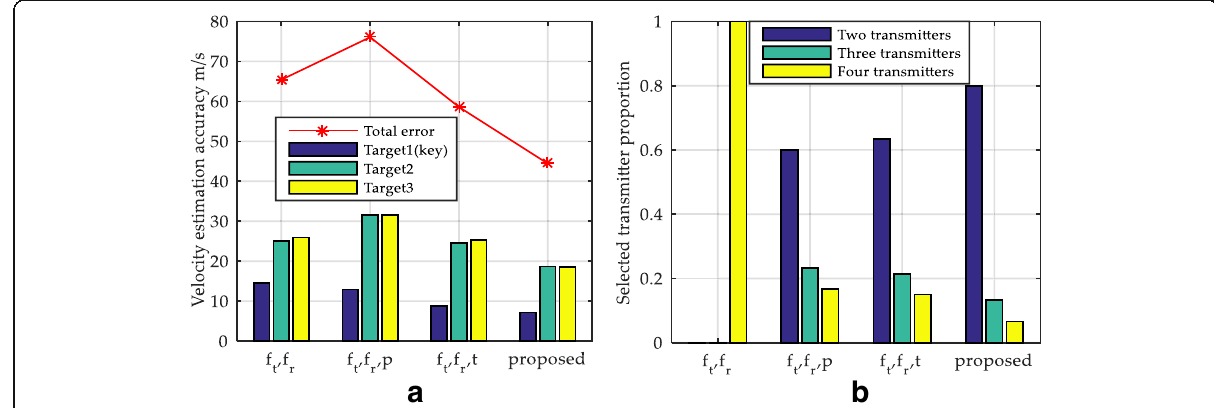
Fig. 5 Velocity estimation accuracy and transmitter number at random layout MSE = [inf, inf , inf]m 2 /s 2 . a Velocity estimation accuracy b transmitter